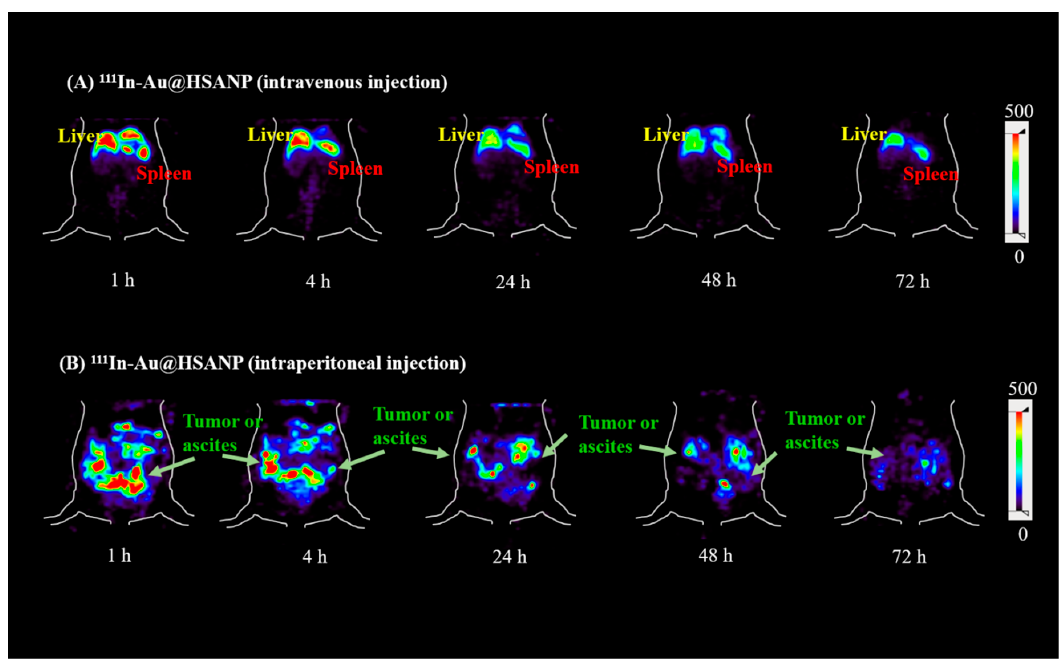
Figure 5. MicroSPECT images of tumor/ascites-bearing CT-26 mice after iv or ip administration of